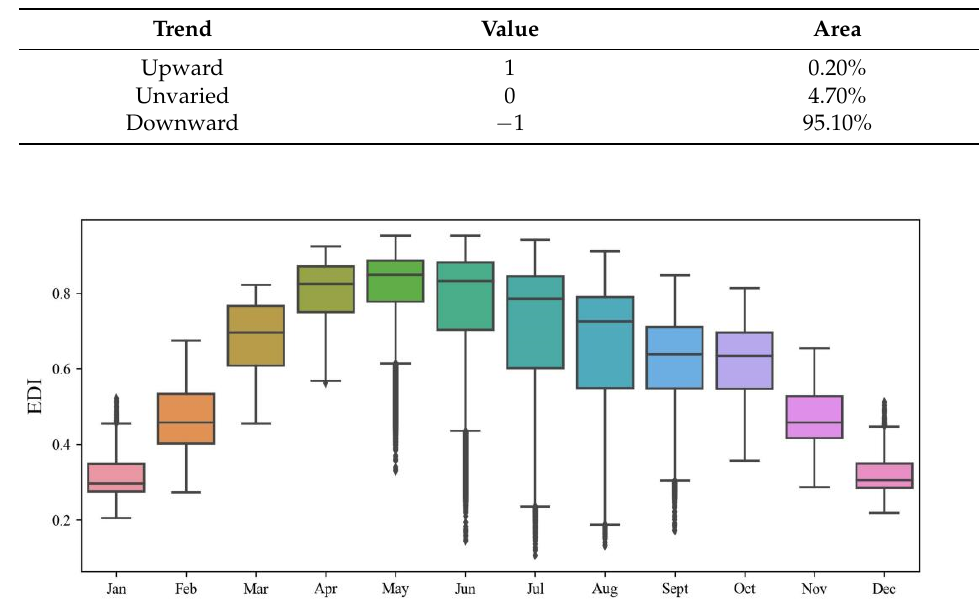
Figure 7. Temporal variation in average monthly EDI.